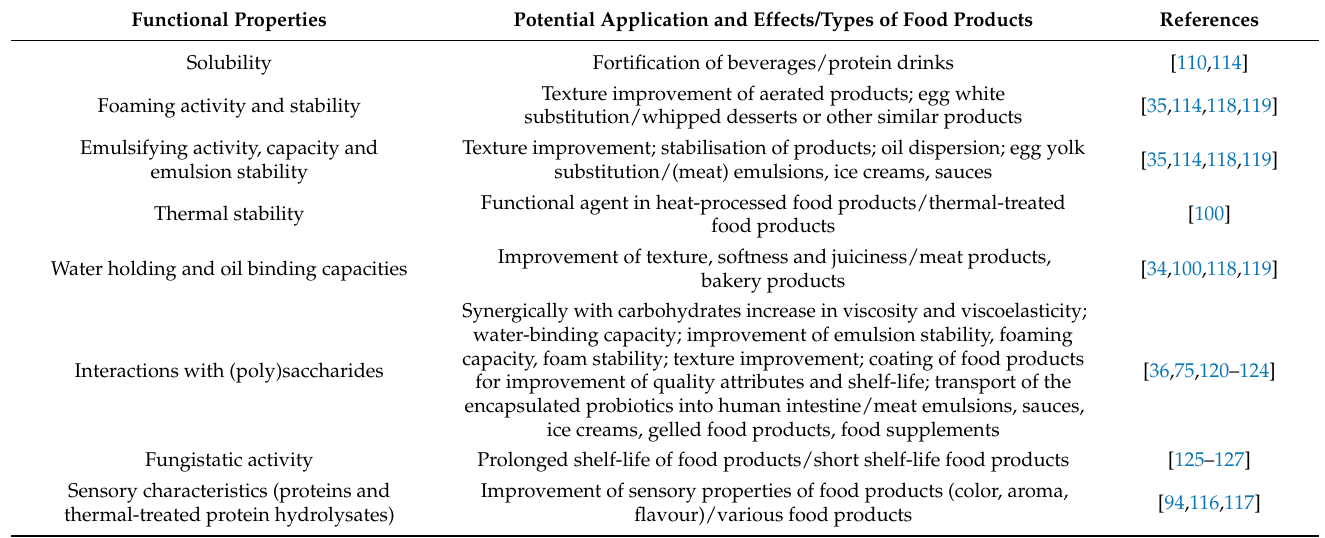
Table 5. Functional properties of flaxseed proteins (including protein hydrolysates) and their potential applications in food